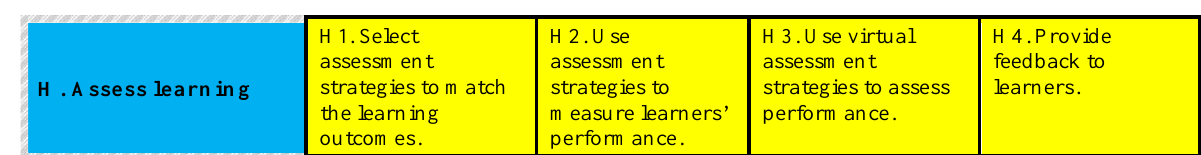
Figure 10. Assessing learning competencies for the digital teacher.